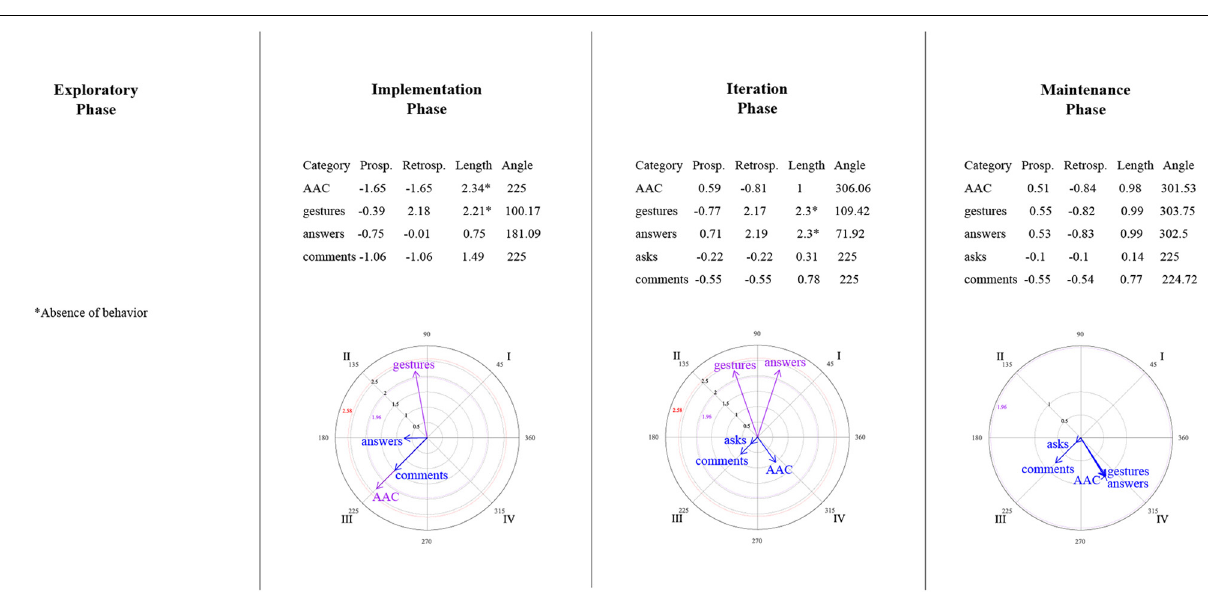
FIGURE 13 | Vectors corresponding to the mother’s giving of the answer to her own questions as focal behavior, and the child’s emotion-related communicative turns [answers, comments, asks] and methods of expression [AAC, conventional gestures] as conditional